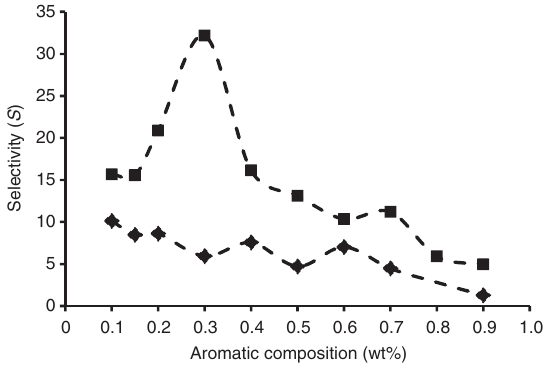
Figure 4: The selectivity at 25 ° C, as a function of the mass fraction of the aromatic in the raffinate for DES1 (diamond symbols) and DES2 (square